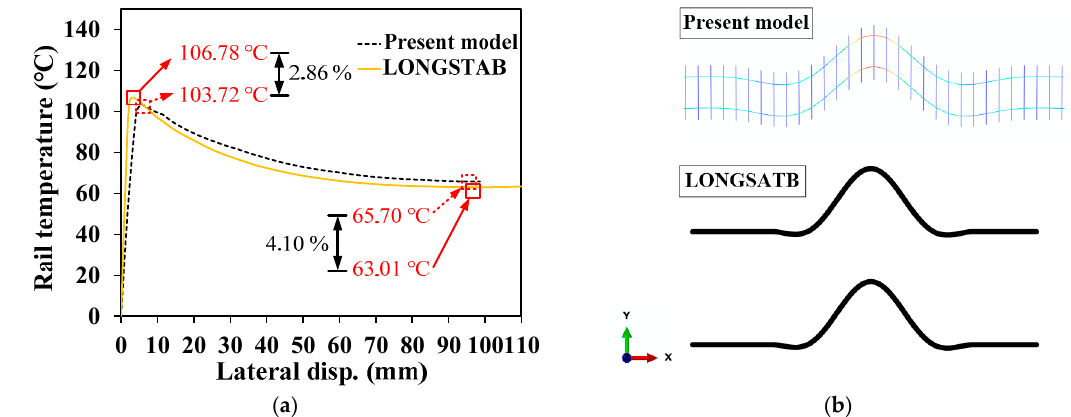
Figure 10. Comparison results with LONGSTAB (track on the embankment region): ( a ) rail temp. vs. lateral disp.; ( b ) comparison of buckling shape.